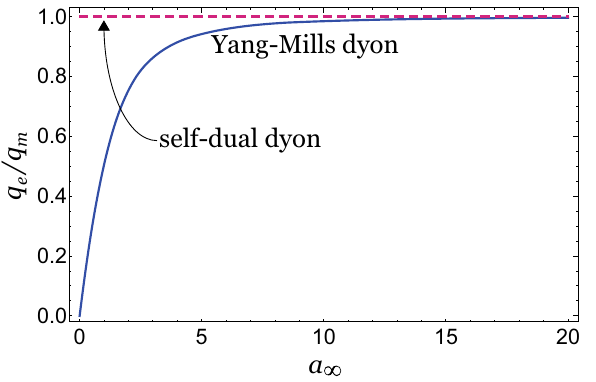
Fig. 10 The ratio of the charges q e / q m as a function of a ∞ for the fixed magnetic charge q m = 4 π/ g . The broken line stands for the SD dyon, while the solid line stands for the Yang–Mills dyon